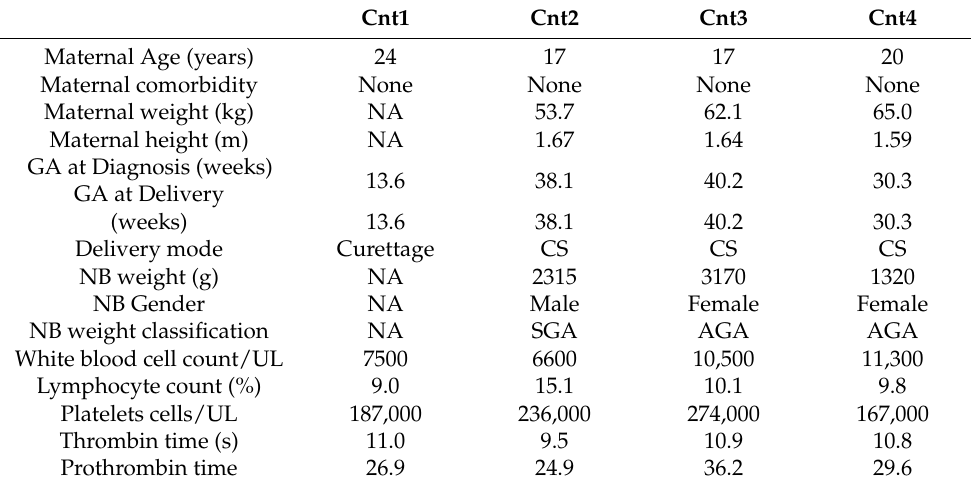
Table 1. Clinical data of control women and their